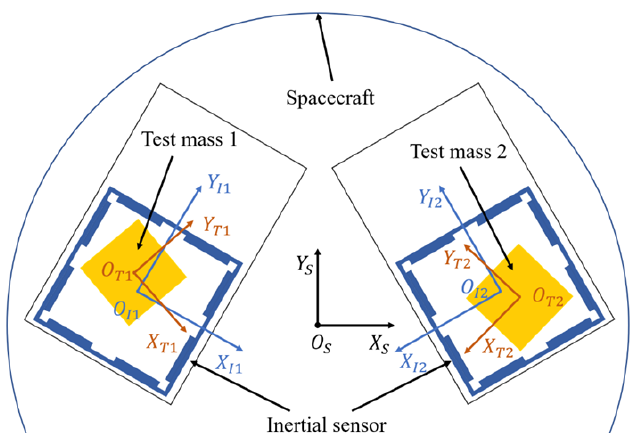
Figure 1. The simplified relative motion coordinate system for drag free spacecraft.